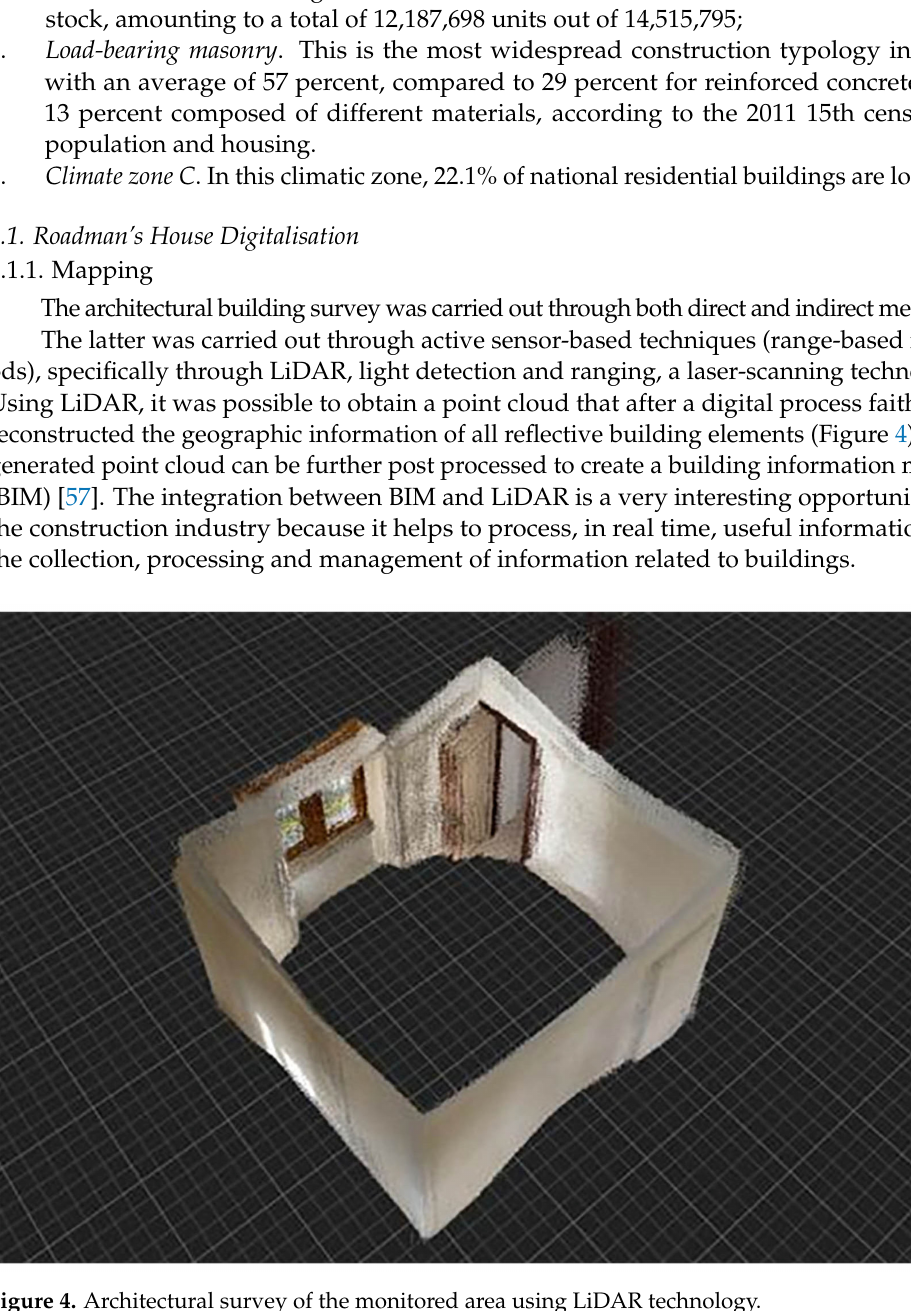
Figure 4. Architectural survey of the monitored area using LiDAR